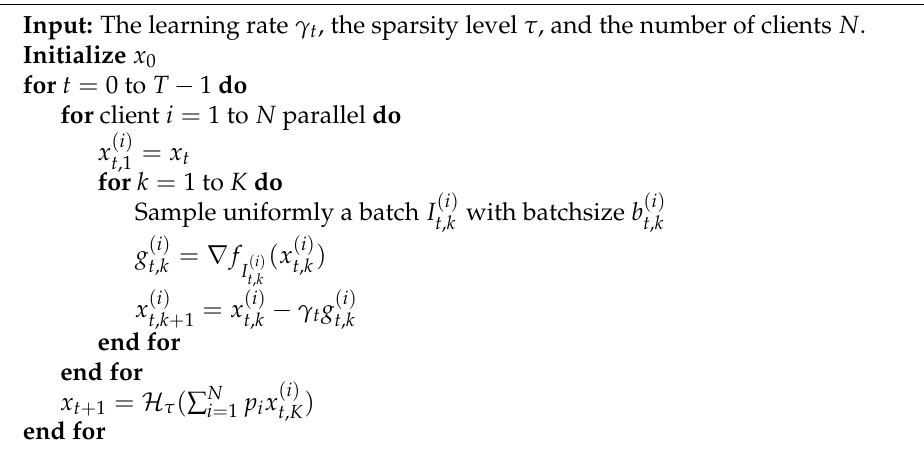
Algorithm 1 Federated Hard Thresholding